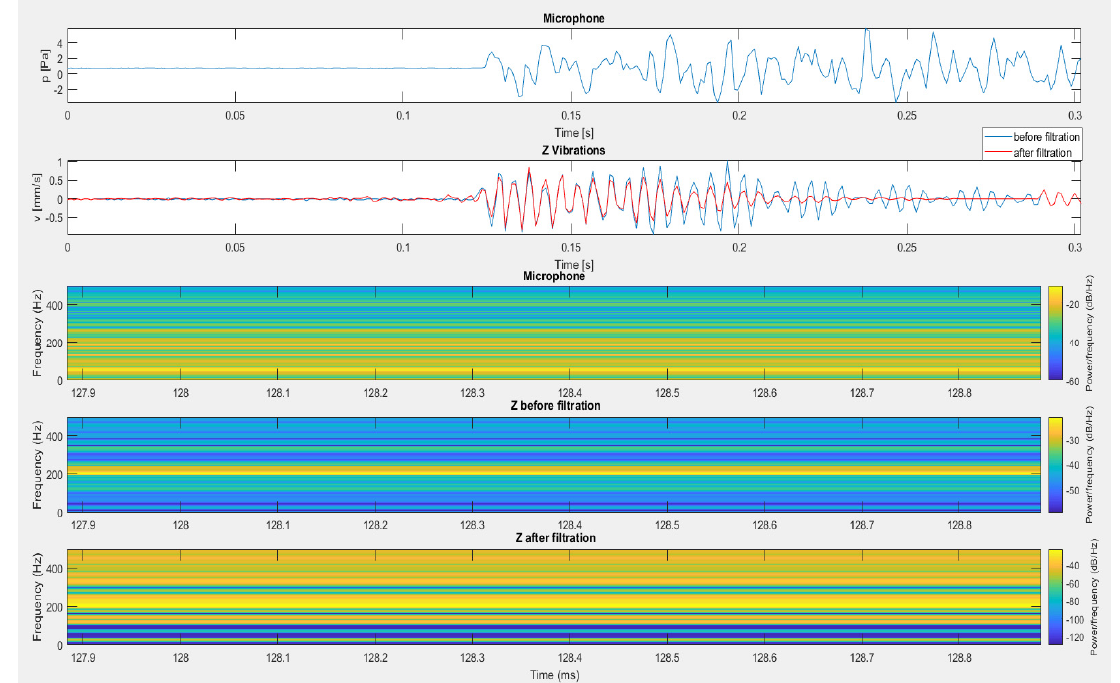
Figure 17. The result of using filtration for the vertical component from a sensor placed inside the building—an internal microphone.